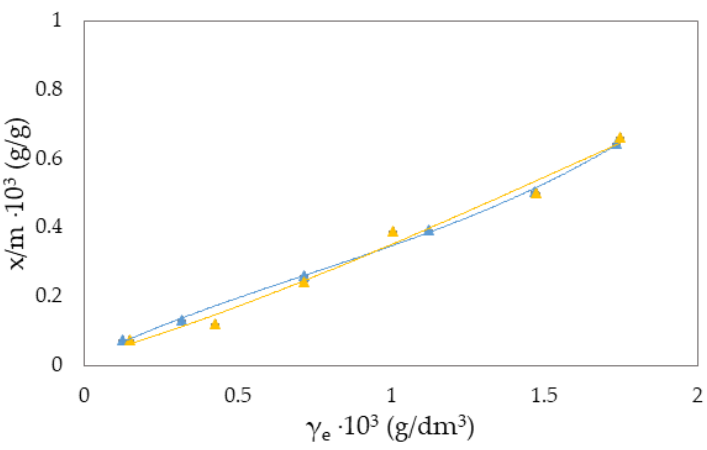
Figure 6. Freundlich adsorption isotherm curves for the suspension MB-NaY at ▲ 283 K and ▲ 293 K.